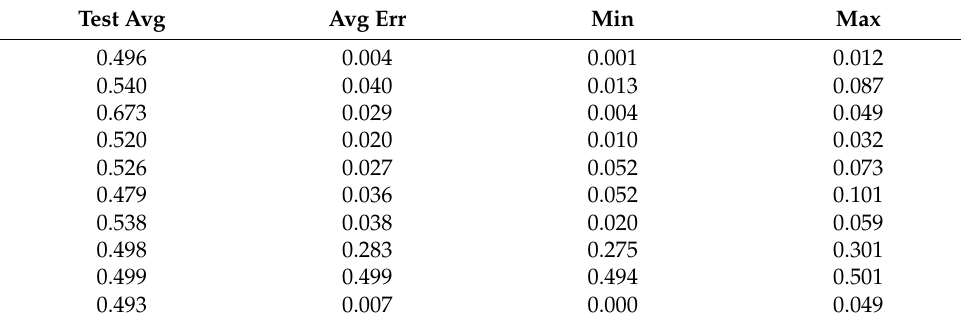
Table A84. Set 2, trials 1–10 data (actual PR value).